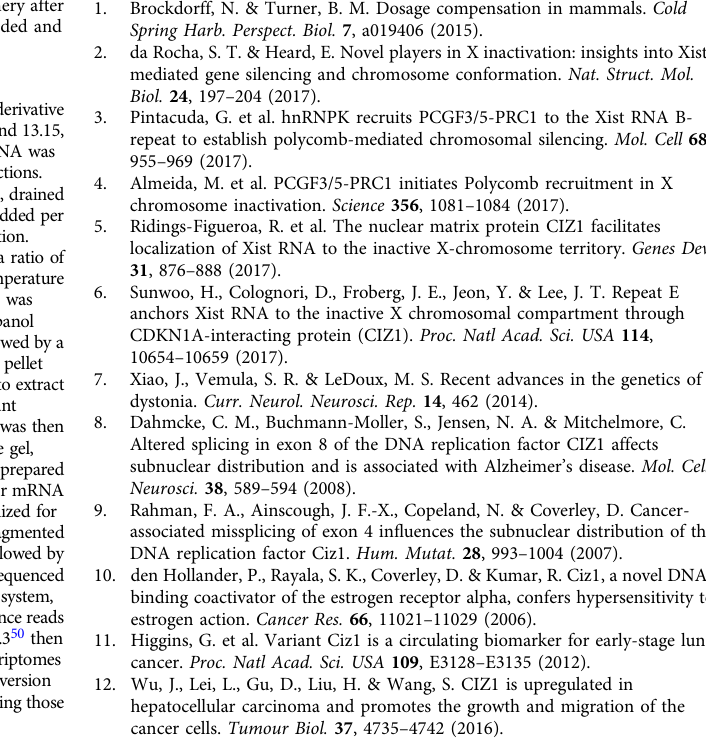
Fig. 1. Xis were classi fi ed as peripheral if any part of its territory or individual foci that are part of a cluster were not resolvable from the nuclear perimeter, con fi rmed by comparison with DAPI. Xis were scored as nucleolar if any part of the territory or foci were unresolvable from fi brillarin stain. Xi which meets both of these criteria were classi fi ed as peripheral/nucleolar, or neither if both of the criteria were not met. (ii) A binary classi fi cation, based on the criteria above (Supplementary Fig. 1), was used